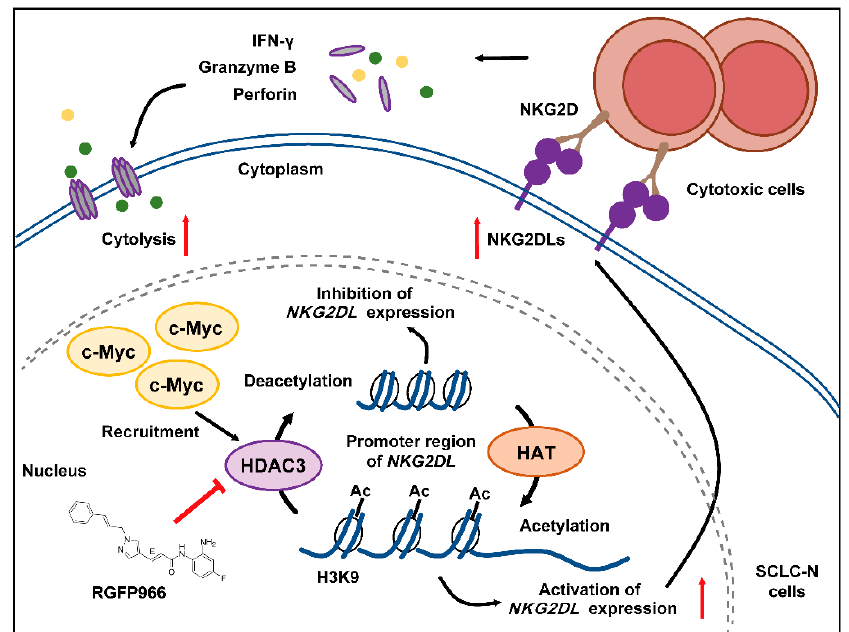
Figure 6. Schematic model of c-Myc regulating the expression of NKG2DL and the cytolysis in SCLC-N. c-Myc recruited and combined with HDAC3, which may facilitate the deacetylation of histone H3K9ac at the NKG2DL promoter region of SCLC-N cells, resulting in the decreased transcription level of NKG2DL and the inability to activate cytotoxic cells and the reduced cell lysis. HDAC3 inhibitor could reverse the decline of the cytotoxic cell killing effect by up-regulating the expression of NKG2DL.